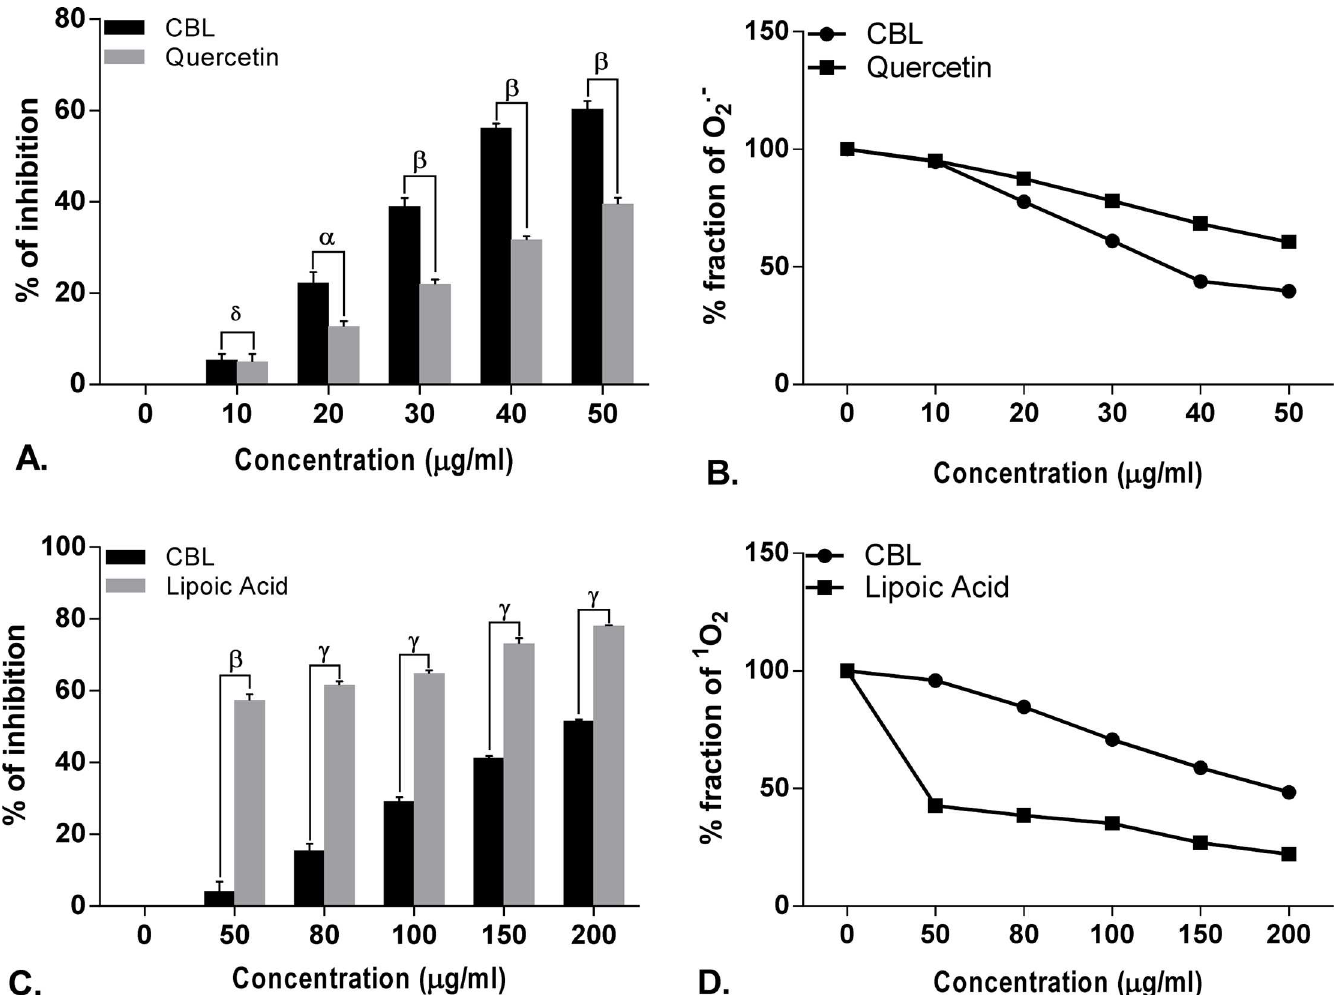
Fig 5. Antioxidant activity of Croton bonplandianus . (A) % inhibition of Singlet O 2 ( 1 O 2 ) Vs standard lipoic acid; (B) depicts unneutralized Singlet O 2 ( 1 O 2 ); (C) % inhibition of Nitric oxide (NO) Vs standard curcumin; (D) depicts unneutralized nitric oxide (NO). Data expressed as mean ± S.D (n = 6). α p < 0.05; β p < 0.01; γ p < 0.001; NS-Non significant when compared with